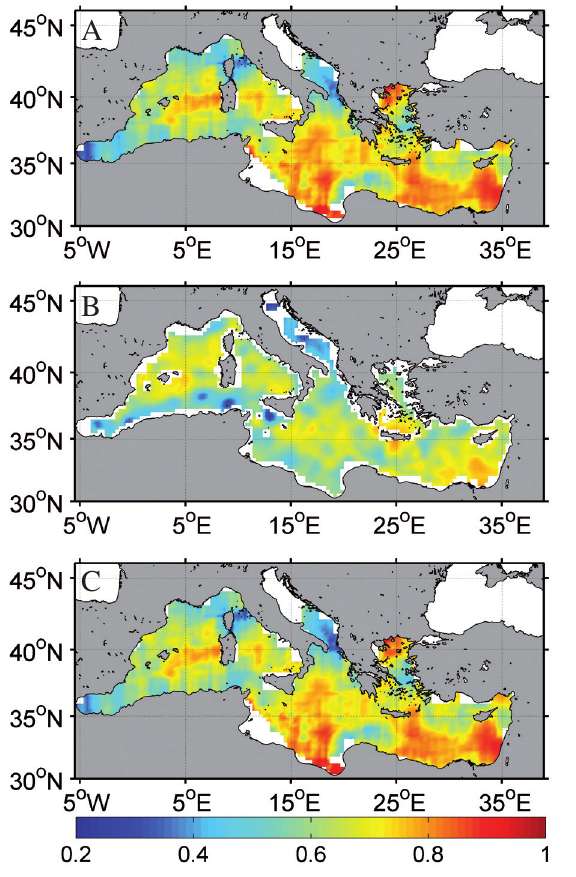
f ig . 3. – Linear correlations between SLA and SSL computed from XBT/MBT bias-corrected (A) and uncorrected (C) in situ profiles and interpolated data (B). Integration depth is in both cases 300 m. Points where correlations are non-significant have been